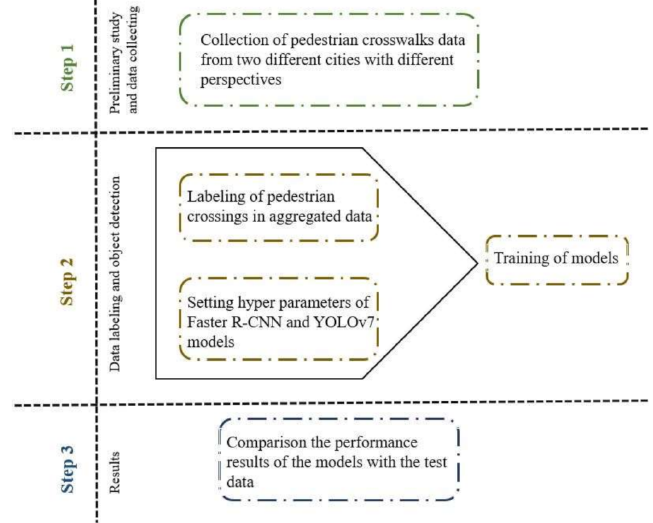
Figure 1. The flowchart of the